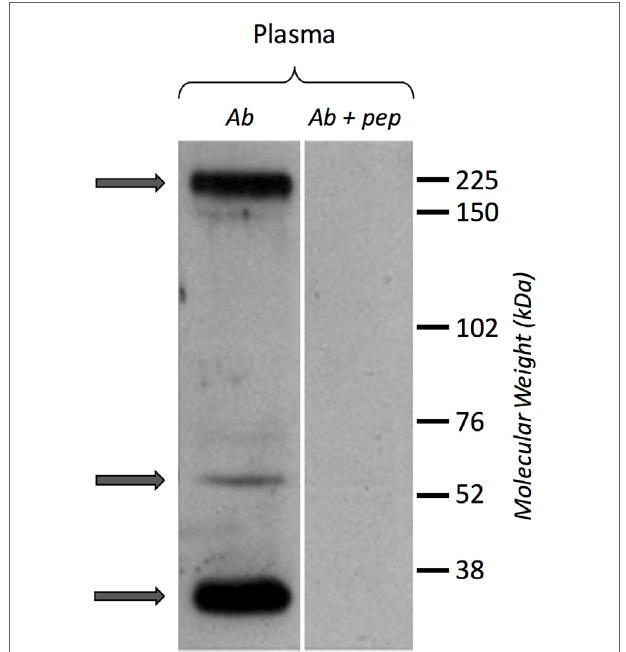
FigUre 4 | BgTEP secretion. Left panel: presence of BgTEP protein on hemolymphatic cell-free compartment was tested by Western blot using an affinity-purified polyclonal antibody (anti-BgTEP-PEP). Ultracentrifuged hemolymph was used to remove hemoglobin. Right panel: as negative control, anti-BgTEP antibody and BgTEP peptide (10-fold molar excess) pre-incubation was performed before incubation with the membrane (Ab + pep). Arrows correspond to the full-length and two processed forms of BgTEP protein present in hemolymph from naïve